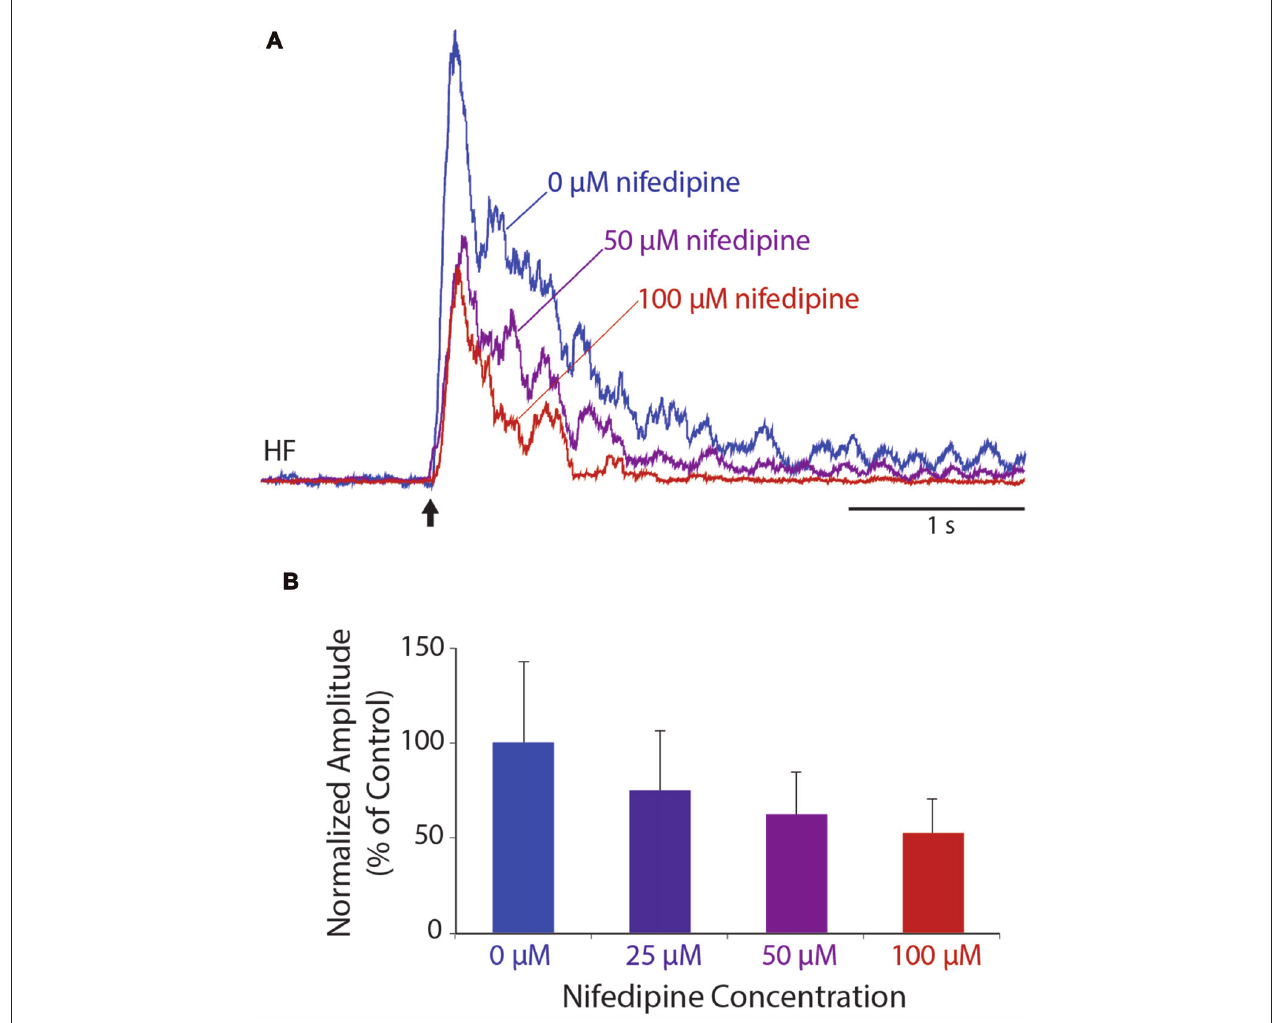
FIGURE 3 | Dose-dependent reduction of an individual flexion reflex by the L-type Ca 2 + channel blocker, nifedipine. (A) Example traces from the HF nerve in response to a 10-g von Frey filament tap to the dorsal hindlimb foot skin, before and during nifedipine application. (B) Dose-dependent reduction in mean amplitude of the HF burst (during the 1-s epoch following each stimulus, normalized to the mean amplitude in control saline) for the animal shown in (A) . Error bars are standard deviations. Flexion reflex was significantly reduced by 100 µ M nifedipine compared to control saline (see “Results” section). All trials were included beginning 15 min after drug application and ending 60 min later or whenever the nifedipine solution was replaced with a higher concentration, whichever came